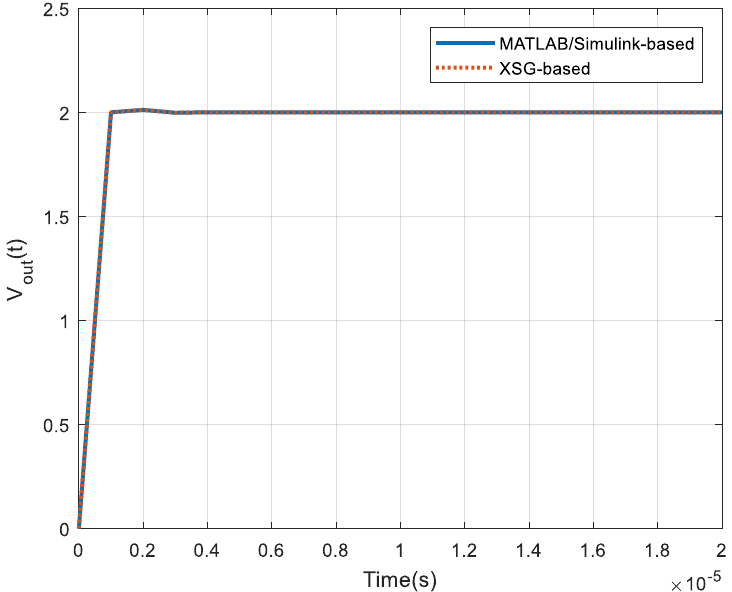
Figure 12. Bitstream to program the Xilinx Artix-7 FPGA board.